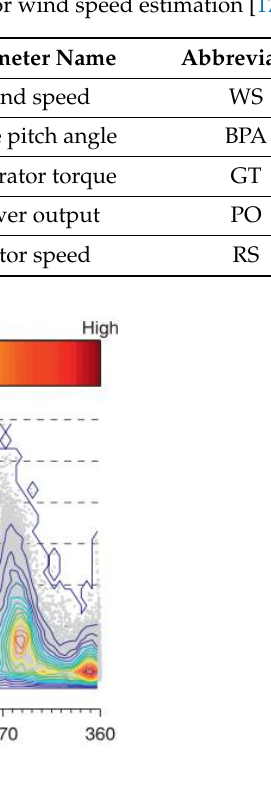
Figure 18. Frequency of wind at 80 m binned by wind speed and direction [18].